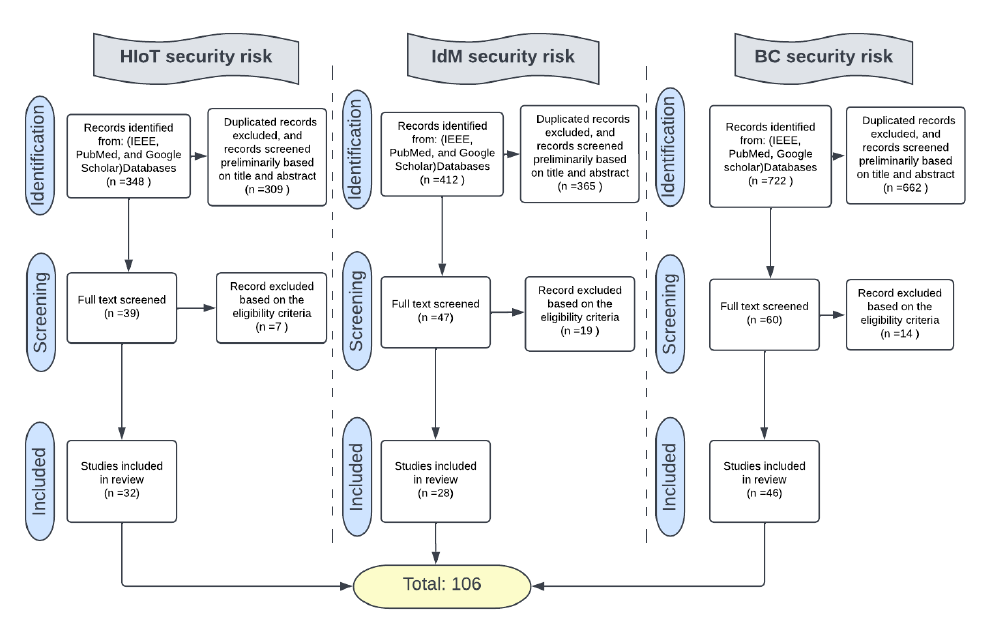
Figure 2. The article selection steps.